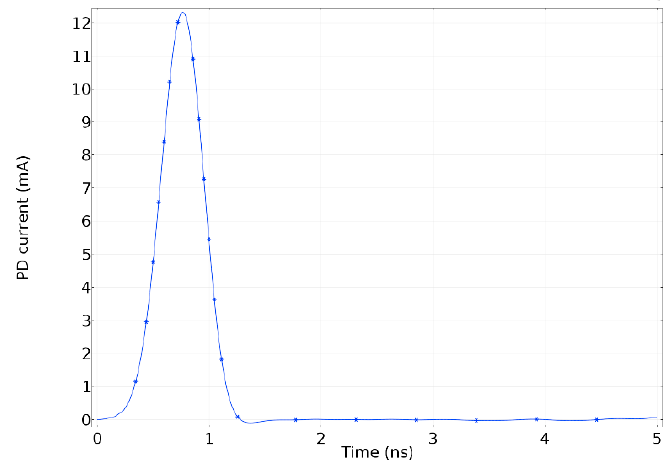
Figure 4. Partial discharge (PD) pulse injected.